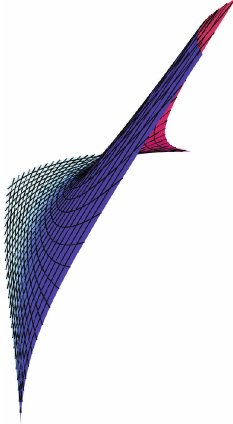
Figure 9: A spacelike surface of constant curvature K (cid:7) − 5 with λ (cid:7) 2, μ (cid:7) A (cid:7) a (cid:7) 1, B (cid:7) 0.